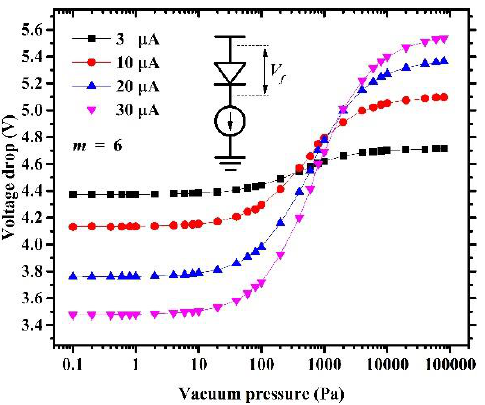
Figure 11. Voltage drop across six series diodes is a function of vacuum pressure and forward bias current.